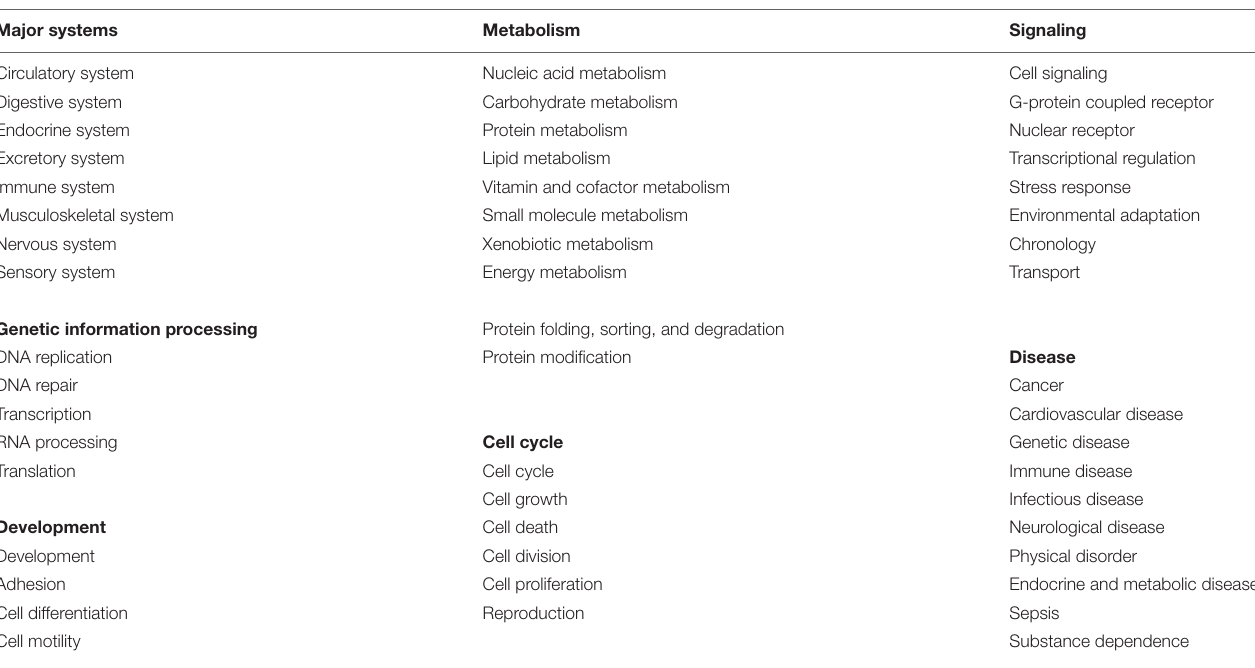
TABLE 2 | Pathway